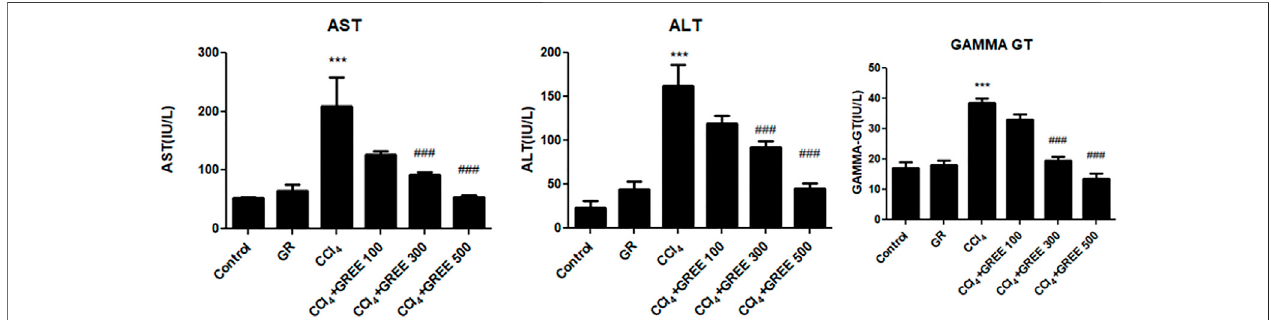
FIGURE 3 | Quanti fi cation of liver damage markers in various treatment groups. Quanti fi cation of AST, ALT, and gamma-GT in the serum of animals from various treatmentgroupswasdeterminedbycommerciallyprovideddiagnostickits.Valuesarerepresentedasthemean±SD, n =4.Signi fi cance:*** p < 0.001 whencompared to group A and ### p < 0.001 compared to group B. Effect of GREE and CCl 4 on blood indices.